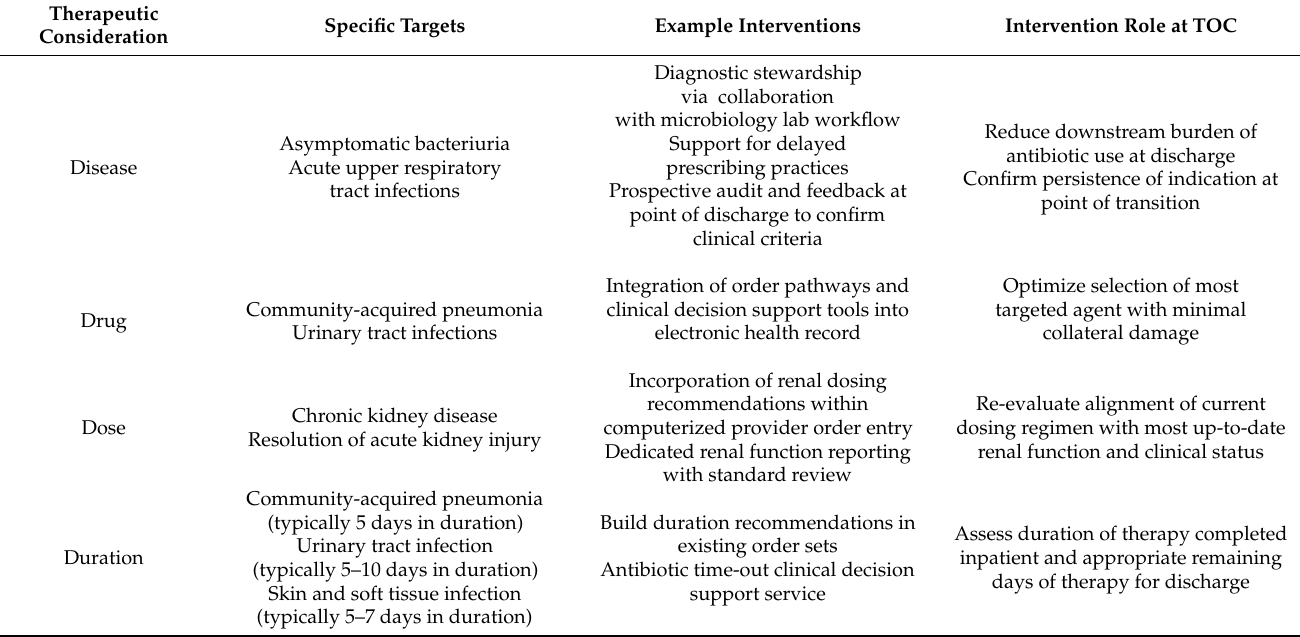
Table 1. Interventional stewardship